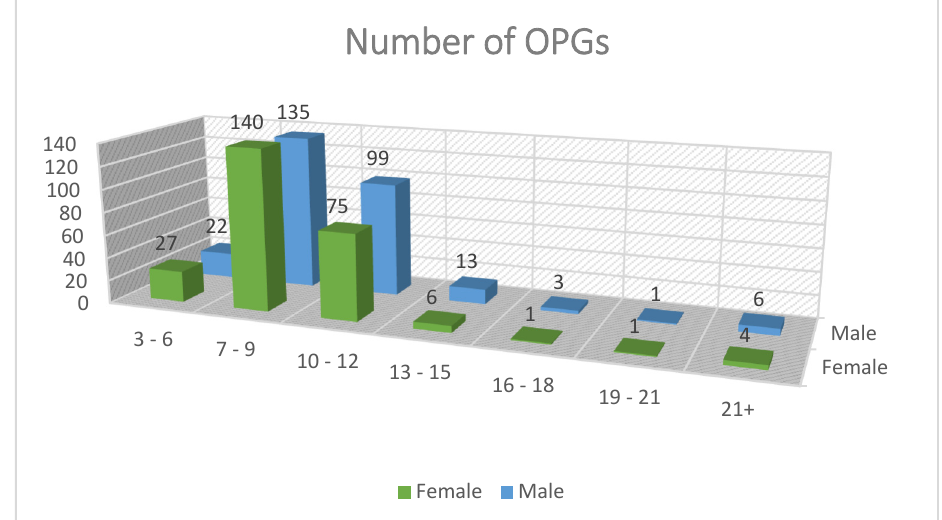
Figure 1. Number of images by gender and age.